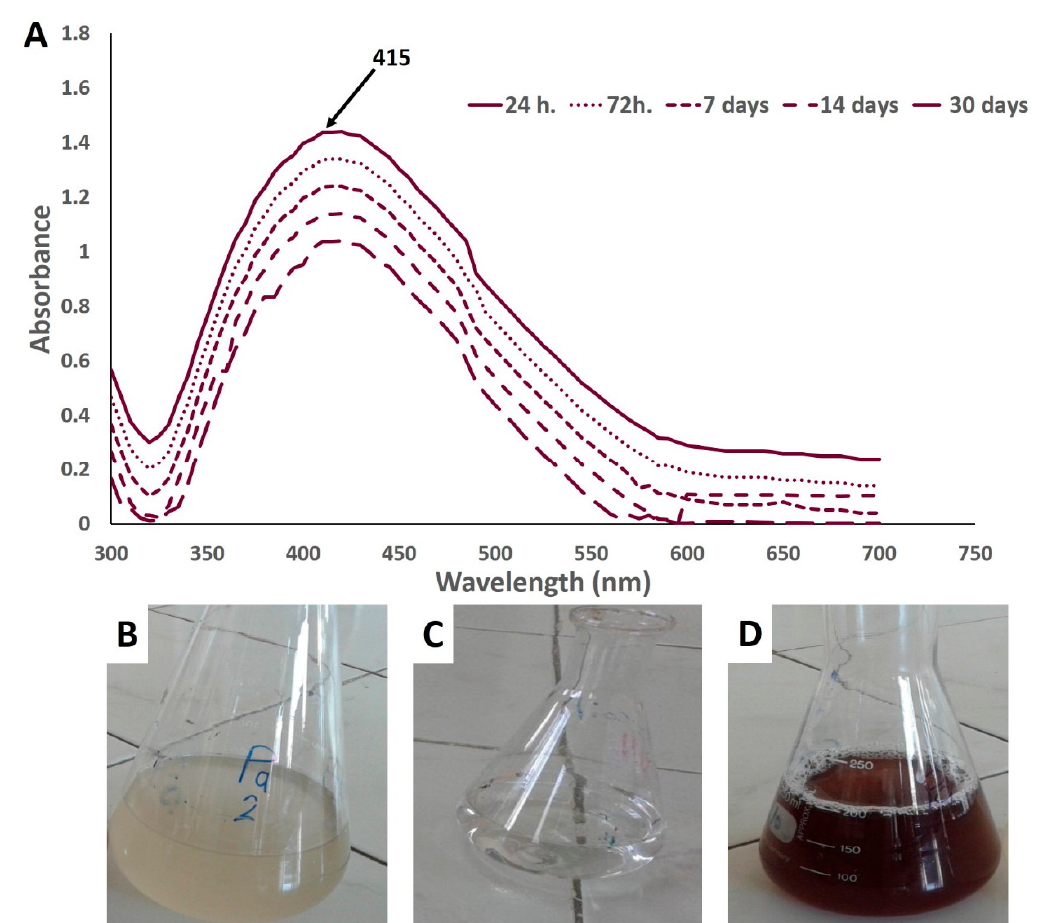
Figure 2. UV–vis spectroscopic analysis and color change of silver nanoparticles (Ag-NPs) synthesized by endophytic S. antimycoticus L-1: ( A ) UV–Vis spectra of Ag-NPs at different interval times; ( B ) biomass filtrate color; ( C ) silver nitrate solution; ( D ) yellowish-brown color of Ag-NPs synthesized by S. antimycoticus L-1.